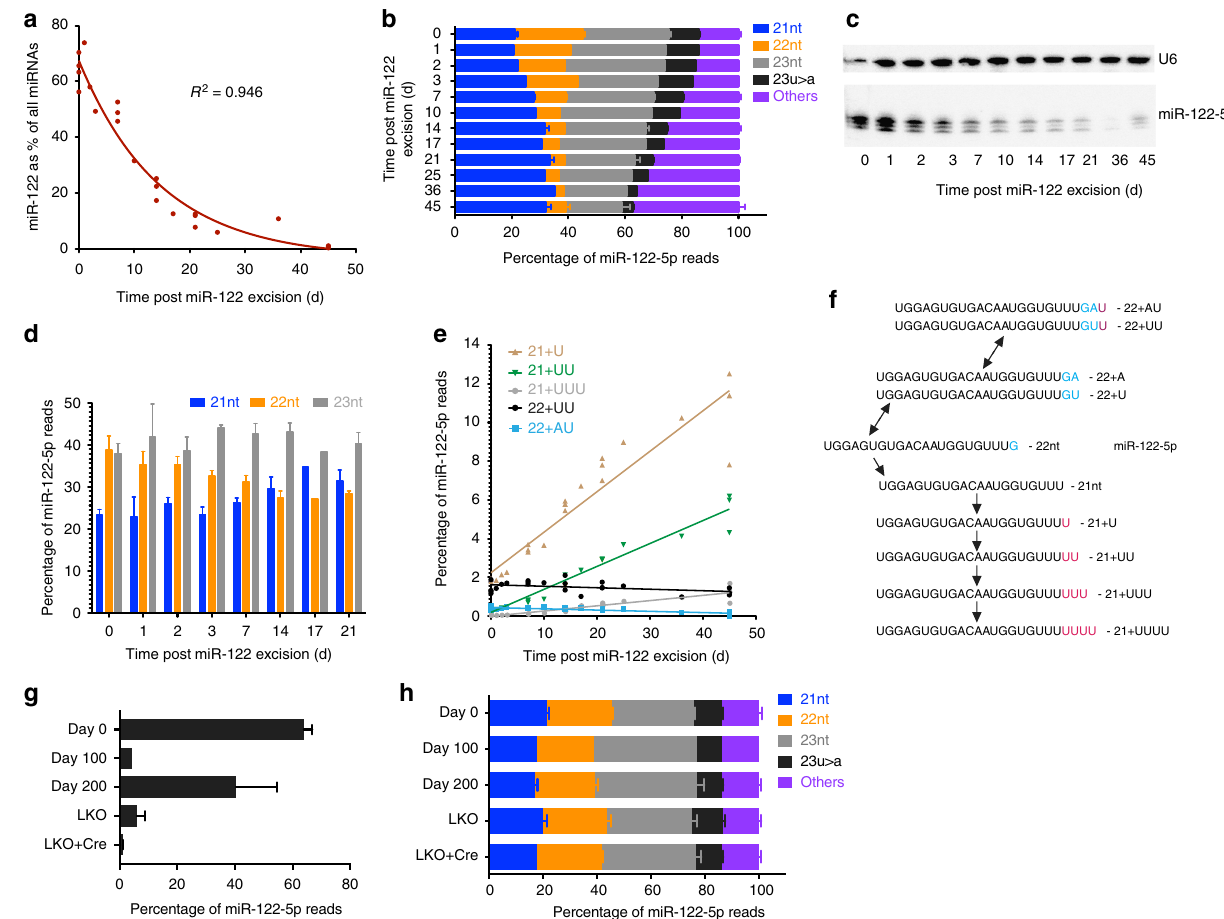
Fig. 1 miR-122 has a consistent degradation pattern but remains expressed from a subset of cells. a Percentage of small RNA-seq reads that map to miR- 122 relative to all other microRNAs in livers of miR-122 fl oxed mice at various time points after receiving 1×10 12 vector genomes of rAAV8-Cre ( n = 1 mouse per point on the graph). b Relative abundance of main isoforms of miR-122-5p from small RNA-seq data ( n = 3 mice for days 0, 7, 14, 21, and 45, error bars are s.e.m.; n = 1 for the remaining timepoints). c Small RNA northern blot of miR-122 expression in mouse livers at various timepoints after miR- 122 excision. d Quanti fi cation of bands from c . e Proportion of rare miR-122-5p isoforms relative to all mapped microRNAs. f Schematic of the processing of miR-122-5p isoforms. g Percentage of miR-122 relative to all microRNAs at longer time periods after miR-122 removal and in mice expressing Cre under the Albumin promoter leading to a liver-speci fi c knockout of miR-122 (LKO) ( n = 3 for days 0 and 200, n = 2 for LKO and LKO + Cre and n = 1 for day 100). h miR-122-5p isoform distributions of samples from g microRNA after excluding counts that map to miR-122. Under mice 18 . Levels of chr12qF1 and Igf2 locus microRNAs were these parameters, as expected, the vast majority of microRNAs initially high in developmental stages and quickly decreased in did not change in relative expression (Supplementary Figure 2). relative abundance after birth (Fig. 3e). When analyzing nor- However, several microRNAs present in imprinted loci became malized small RNA-seq data 3 from mice with and without miR- markedly activated over time including miR-483 and miR-675 at 122 − / − (after removing read counts that map to miR-122), the Igf2 locus and nearly all microRNAs on the Dlk1-Dio3 locus chr12qF1 and Igf2 locus microRNAs are notably activated on mouse chromosome 12qF1, represented by miR-127 and miR- (Fig. 3f), which matches the levels of chr12qF1 and Igf2 micro- 376a (Fig. 3a, b). Activation of microRNAs at the chr12qF1 locus RNA levels in Mir122 knockout mice (Fig. 3g). The expression of alone has been implicated in the development of hepatocellular chr12qF1 and Igf2 locus microRNAs continues to increase even carcinoma (HCC) in several contexts 14,15 including in miR-122 after the 100-day timepoint when miR-122 becomes re-expressed, though they begin to taper off. Immunohistochemistry of mouse knockout mice 16 and is a signature we have also found in liver sections 200 days after rAAV-Cre indicates marked fi brosis Kras G12D -induced lung adenocarcinoma 17 , though notably the as has been described for miR-122 knockout mice (Supplemen- mouse lung cancer samples did not have activated miR-483 or tary Figure 3) 12,18 . Together this suggests a mechanism con- miR-675 expression. Consistently increased expression of the necting miR-122 loss with microRNAs implicated in the combined chr12qF1 locus microRNAs (but not a control micro- development of HCC. RNA, miR-21) is observed when comparing microRNA read counts from small RNA-seq of miR-122 − / − mice relative to their age-matched wild-type counterparts (Fig. 3c, d). Delivery of miR- Other miRNAs have improved repressiveness without miR- 122 by rAAV vectors reduces imprinted microRNA levels at the chr12qF1 locus in miR-122 knockout mice (Fig. 3d) and may 122 . To elucidate how targets of miR-122 and other microRNAs explain the reduction in tumor incidence when miR-122 is are affected by the loss of miR-122, we performed RNA-seq on administered by hydrodynamic tail vein injection to miR-122 − / − mouse liver samples at various stages (21, 45, and 200 days) after NATURE COMMUNICATIONS| (2018) 9:5321